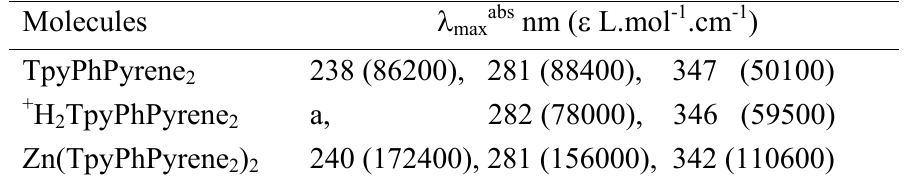
Table 1. Absorption data in acetonitrile solutions (molar absorption coefficient) for the three different systems containing the bis pyrene